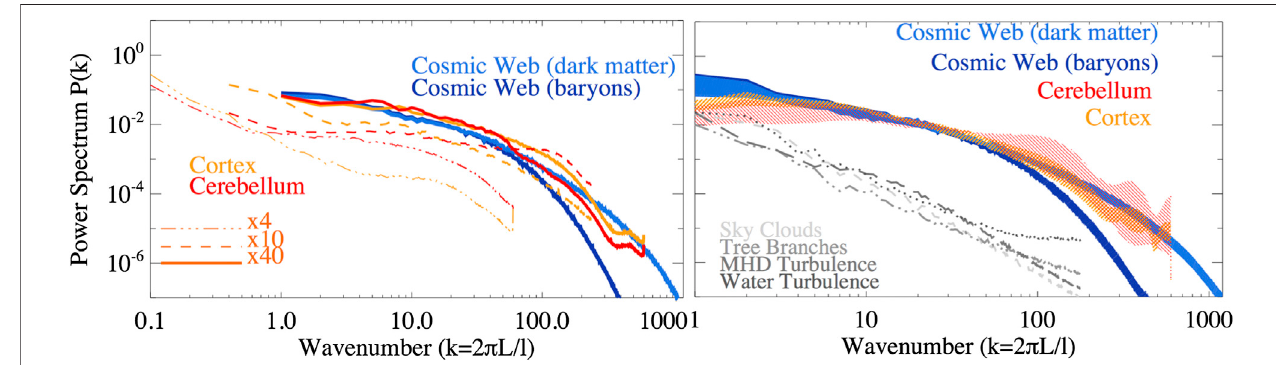
FIGURE2| Left:power spectraofdensity fl uctuationsinallsamples(inthecaseofbrainsamples,spectrafromslicesofdifferentsizeandmagni fi cationfactors are shown).Right:power spectraofdensity fl uctuations(inthecaseofbraintissues,onlythe40 × slicesareused here),withshaded areas enclosing theentiredistribution of spectraforallsamples(12slicesforcosmicwebsamplesandfourforthebrainsamples).Comparisonpowerspectrafromothersamplesnaturalsystemsareshownwith gray lines.